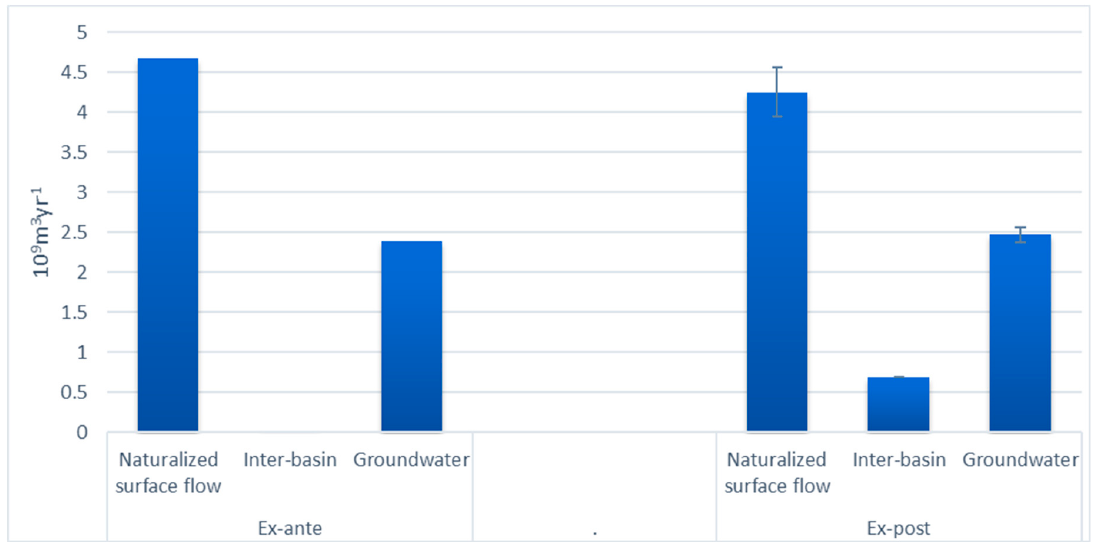
Figure 4. The Urmia Lake Basin ex-ante (2000–2010) and ex-post (2020–2030) Availability for the ex-ante and ex-post periods; the error bars represent the uncertainty range under the low climate change scenario (RCP2.6) and the higher climate change scenario (RCP8.5) (for naturalized surface flow) and the business-as-planned and business-as-usual scenarios (for groundwater).